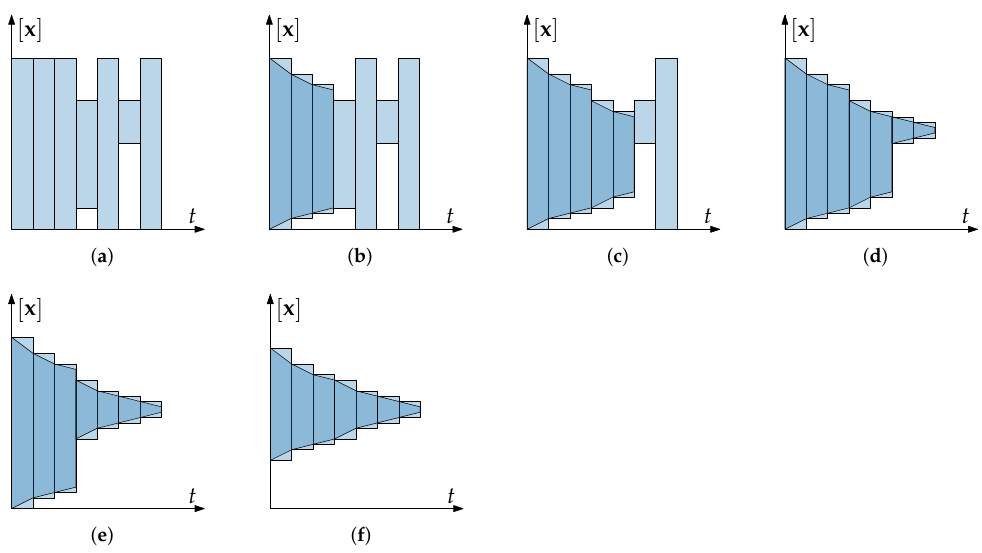
Figure 9. Lohner contractor’s working principle. ( a ) Initial tube [ x ]( · ) . ( b ) Contraction of the first three slices: C Lohner considers [ x k ] ∩ [ x ]( t k ) to compute [ x k + 1 ] . ( c ) Contraction of the two next slices: C ) to compute [ x ] ∩ [ x ]( t ] . ( d ) Contraction of the remaining slices in forward [ x k Lohner considers k k + 1 mode. ( e ) Beginning of backward mode. ( f ) Contracted tube C Lohner ([ x ]( · ))